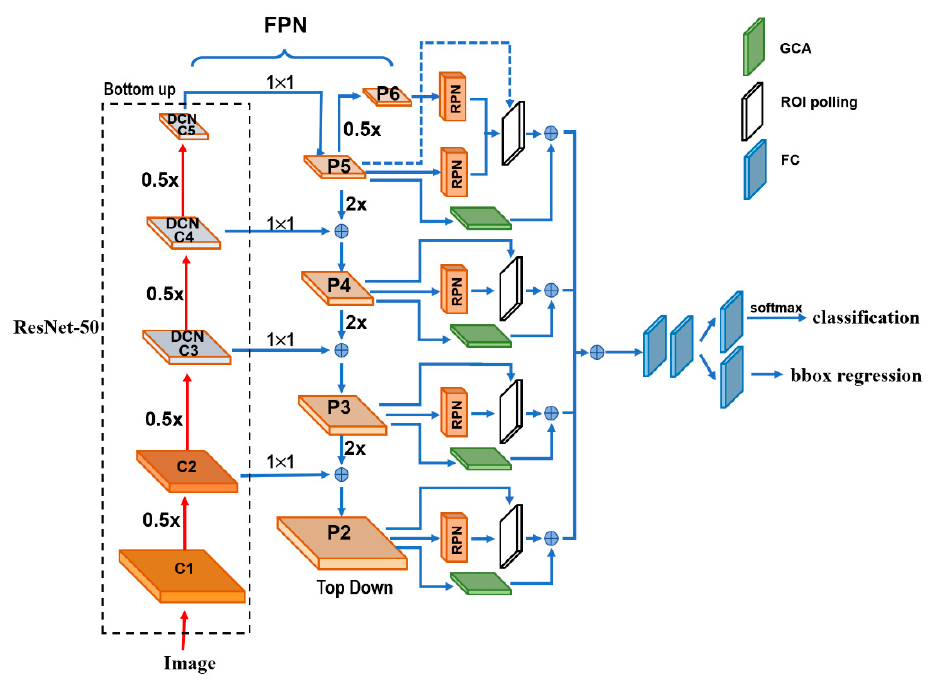
Figure 1. A schematic illustration of the proposed DGCA-RCNN architecture.